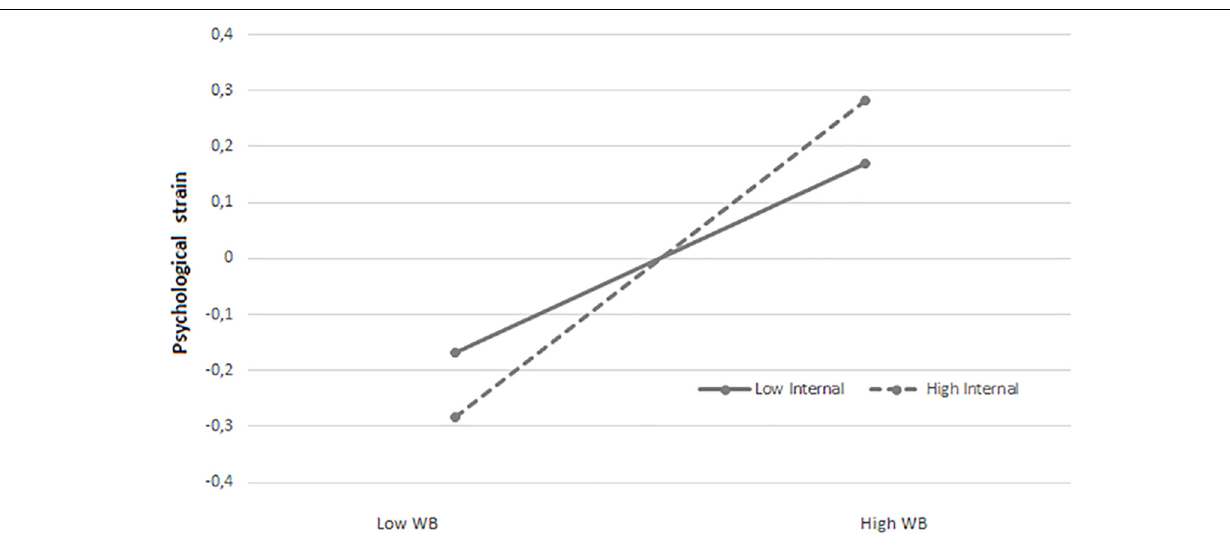
Frontiers in Psychology |